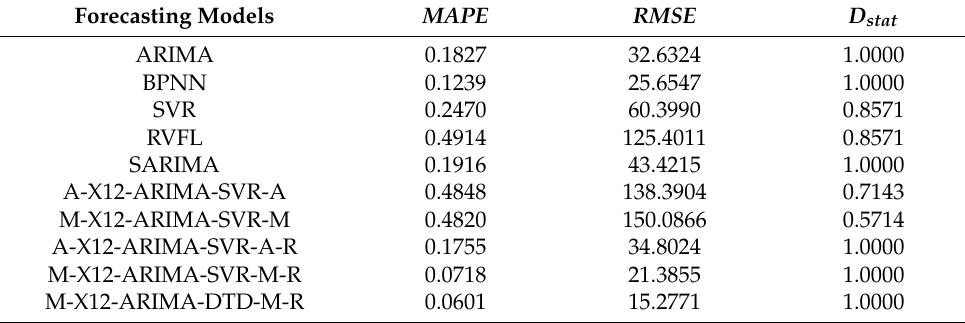
Table 13. Performance comparison of different models in Henan.